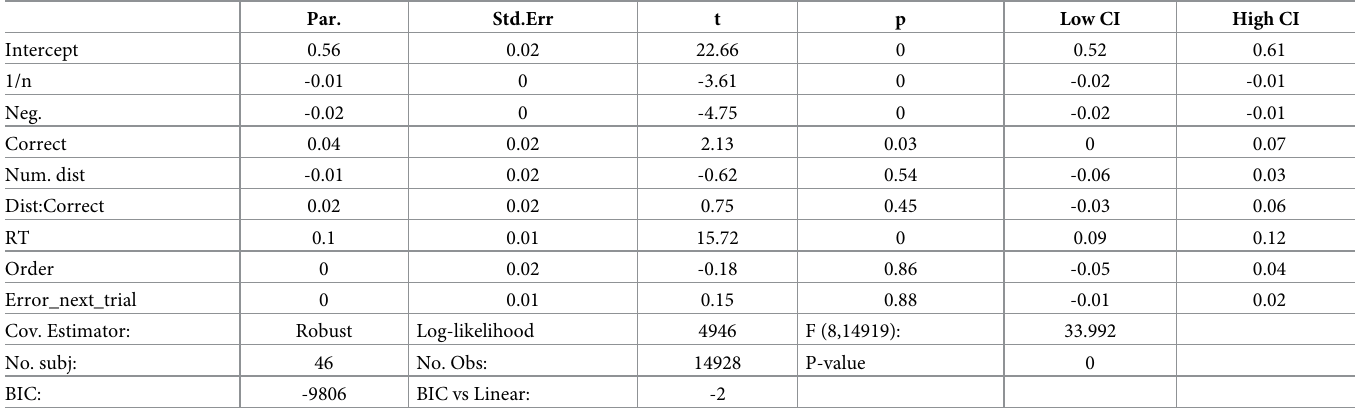
Table 2.3. Max. Press. Exp 2. Random Effects Estimation.